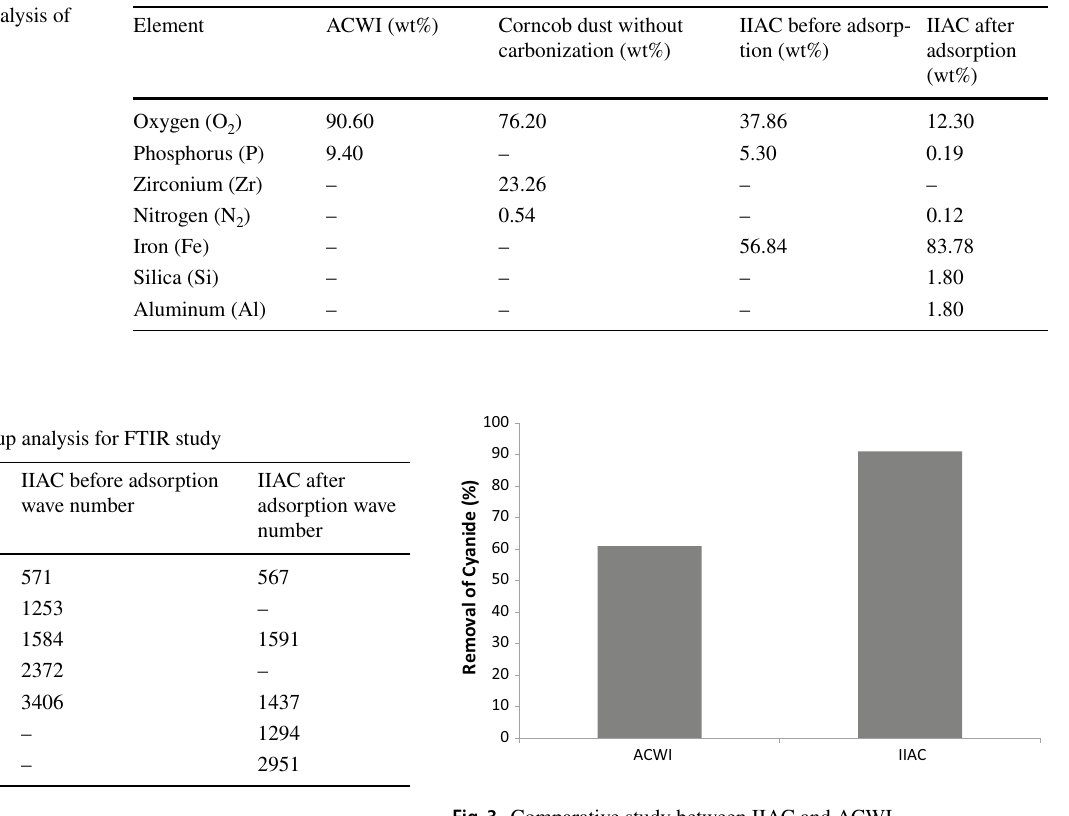
Fig. 3 Comparative study between IIAC and